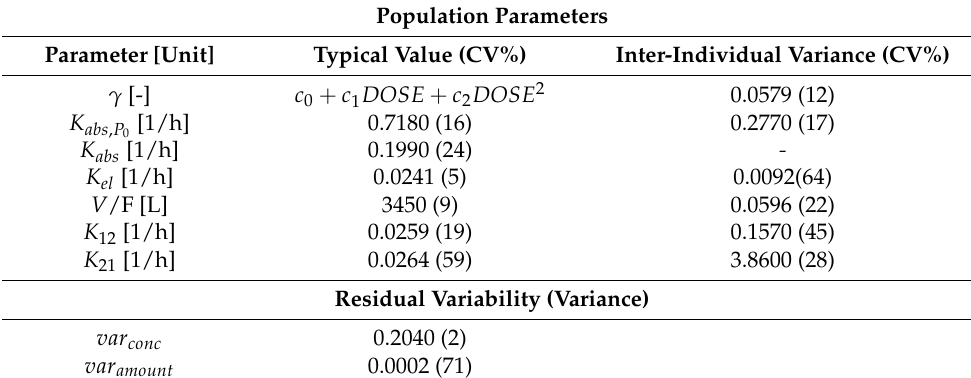
Table 7. Parameter estimates of the population IVIVC P-ring model.